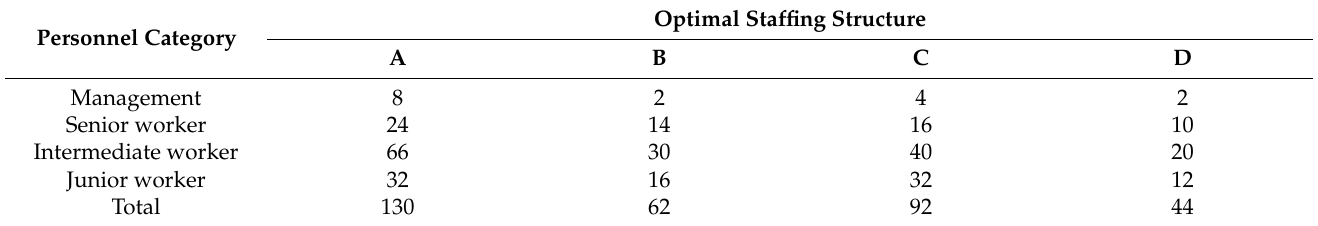
Table 14. Optimal staffing